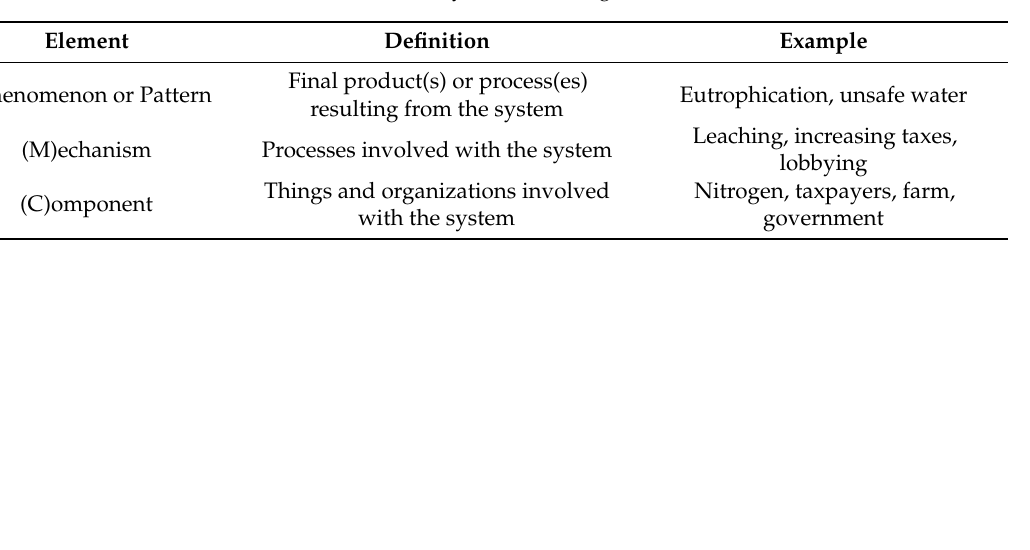
Table 1. Elements of a systems thinking model